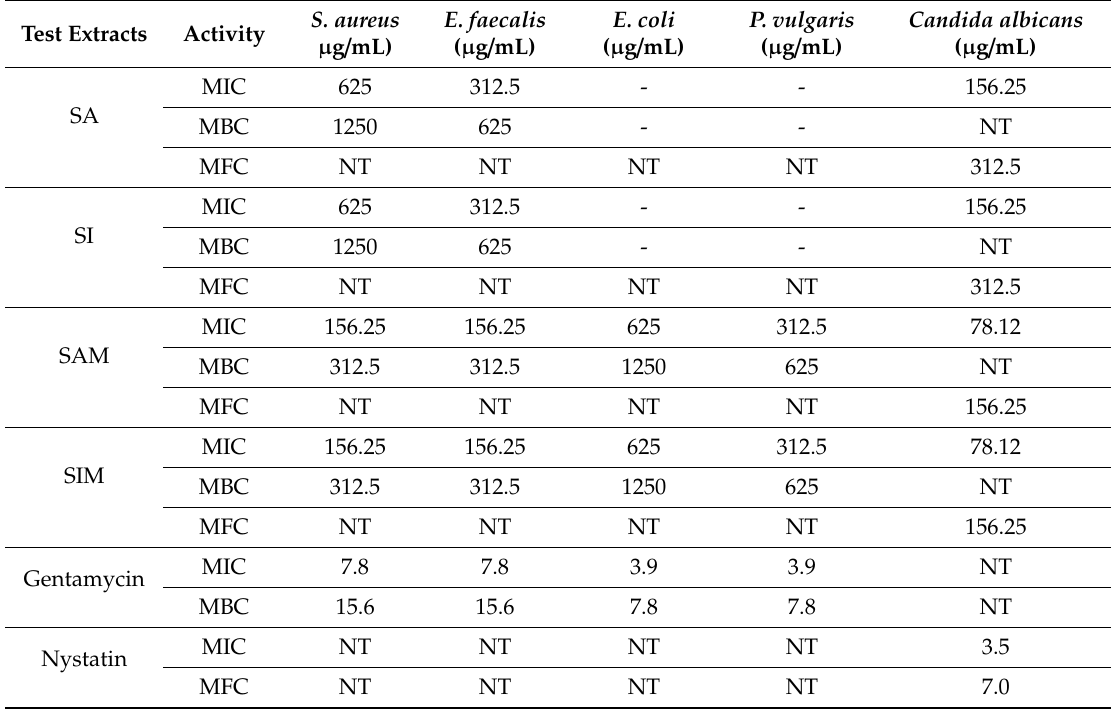
Table 3. Minimal inhibitory concentrations (MICs), minimal bactericidal concentrations (MBCs), and minimal fungicidal concentrations (MFCs) of SA, SAM, SI, and SIM. Test